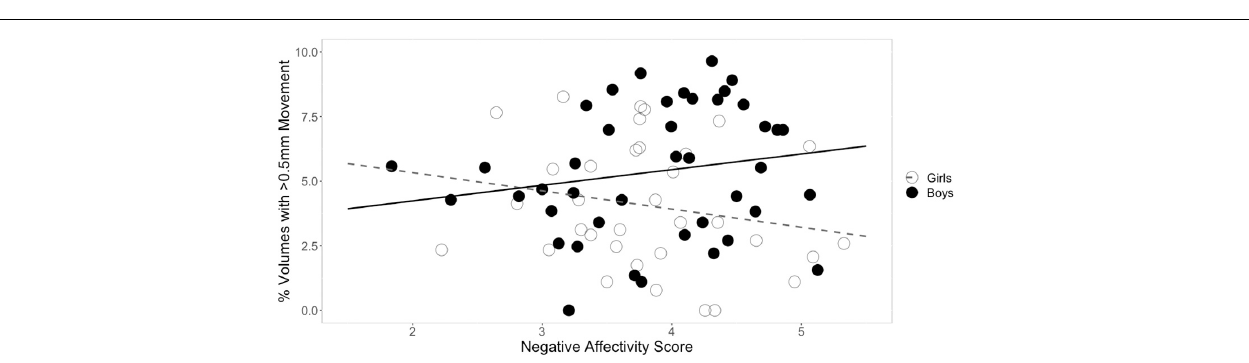
FIGURE 1 | Sex differences in the relationship between effortful control and movement. The square root of percent of volumes with greater than 0.5 mm of movement are plotted on the y -axis. For boys, effortful control was negatively correlated with movement. This relationship was not significant in girls.